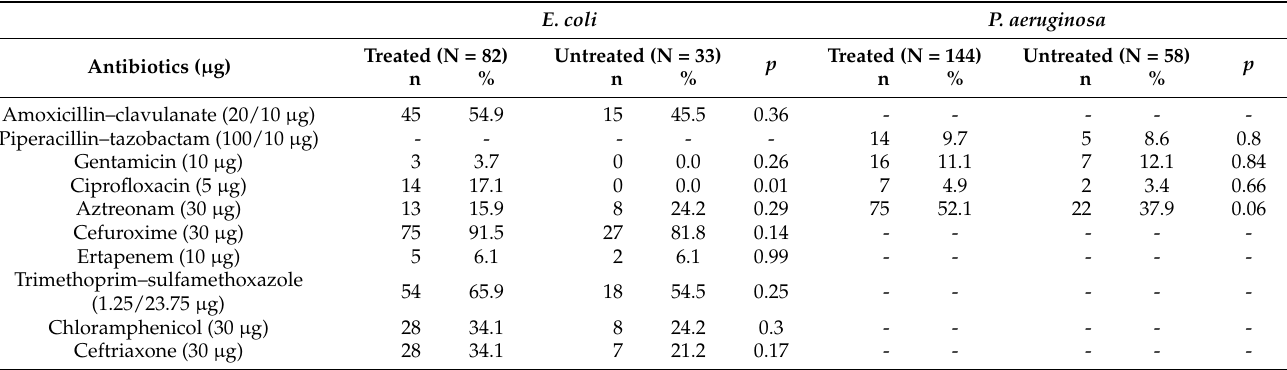
N: number of total isolates; n: number of resistant isolates; -: antibiotic was not tested against isolates. The proportion of MDR E. coli detected was 58.3%, whilst only 4.5% P. aeruginosa isolates were MDR. E. coli isolates from borehole water samples were more likely to be MDR, (72.7%; 8/11), followed by tap water (64.6%; 51/79) and well water (32.0%;